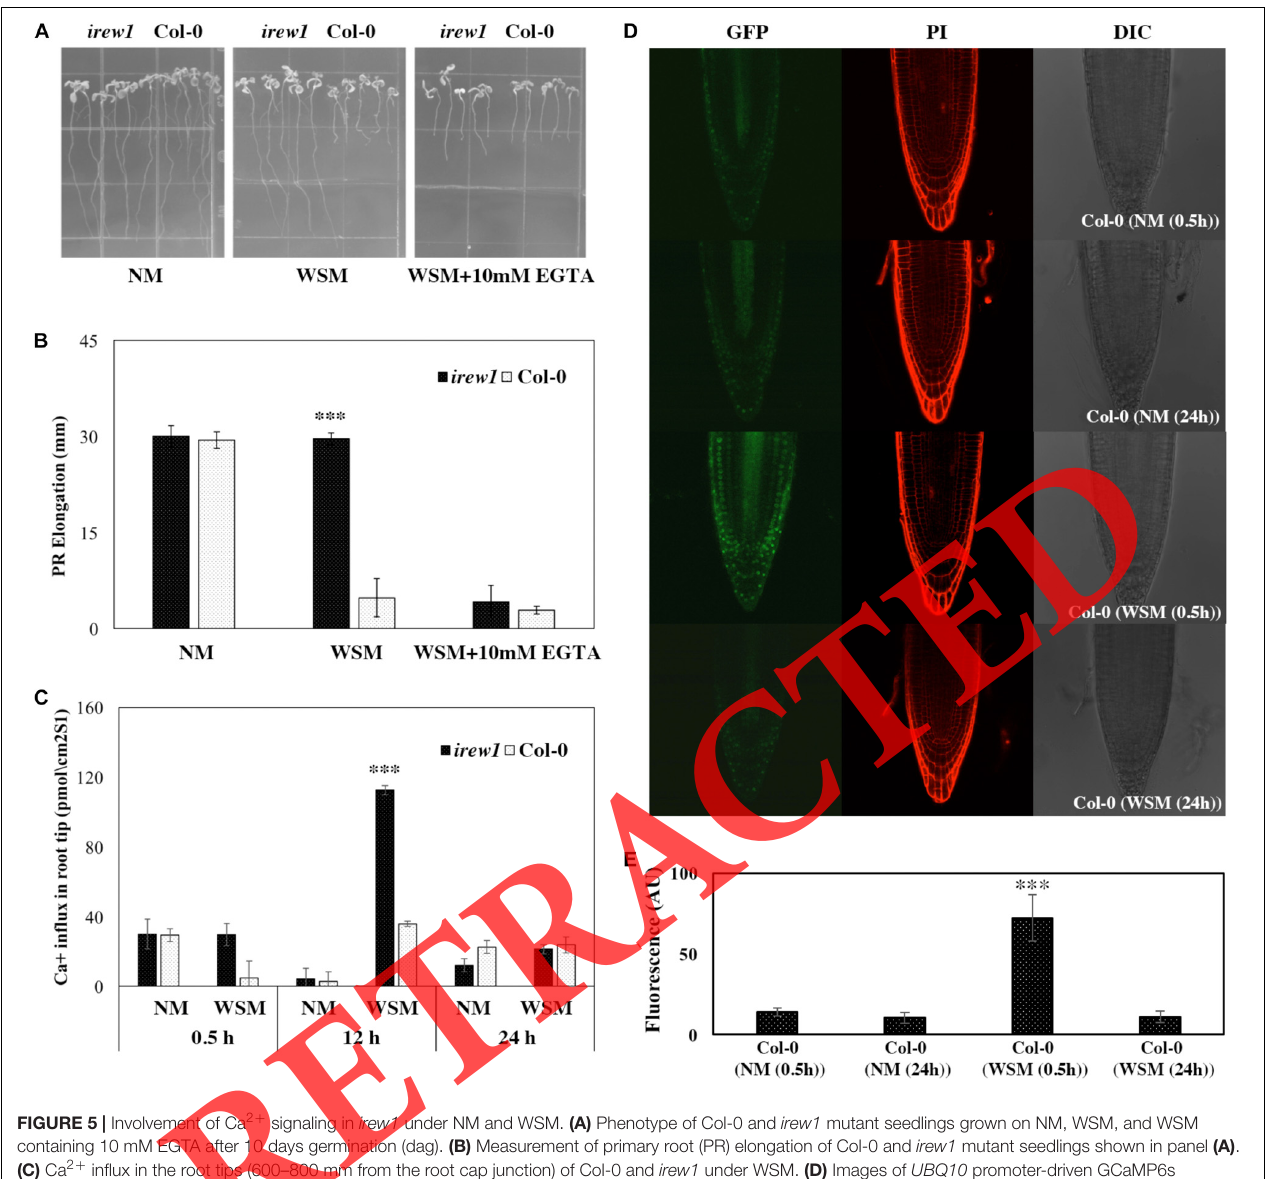
FIGURE 5 | Involvement of Ca 2 + signaling in irew1 under NM and WSM. (A) Phenotype of Col-0 and irew1 mutant seedlings grown on NM, WSM, and WSM containing 10 mM EGTA after 10 days germination (dag). (B) Measurement of primary root (PR) elongation of Col-0 and irew1 mutant seedlings shown in panel (A) . (C) Ca 2 + influx in the root tips (600–800 mm from the root cap junction) of Col-0 and irew1 under WSM. (D) Images of UBQ10 promoter-driven GCaMP6s fluorescence on NM at 0.5 h or 24 h, and on WSM at 0.5 h or 24 h, respectively. (E) Fluorescence intensity (AU) shown in panel (D) . The values are means, and error bars show ± SD of six biological replicates from two independent experiments ( n = 12). Student’s t -test was performed. *** p < 0.001 by Student’s t